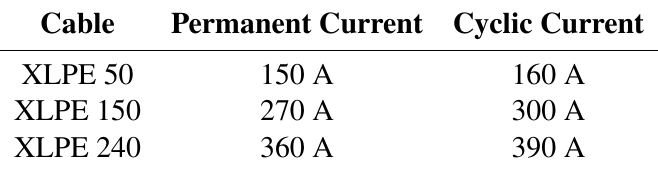
Table 3. Cable ampacity.